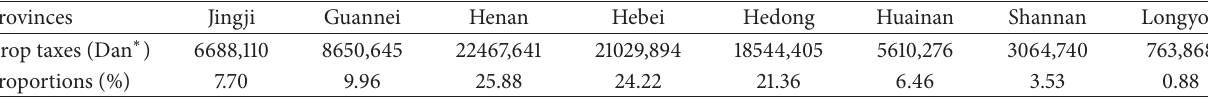
Table 1: The provincial crop taxes recorded in 749 AD